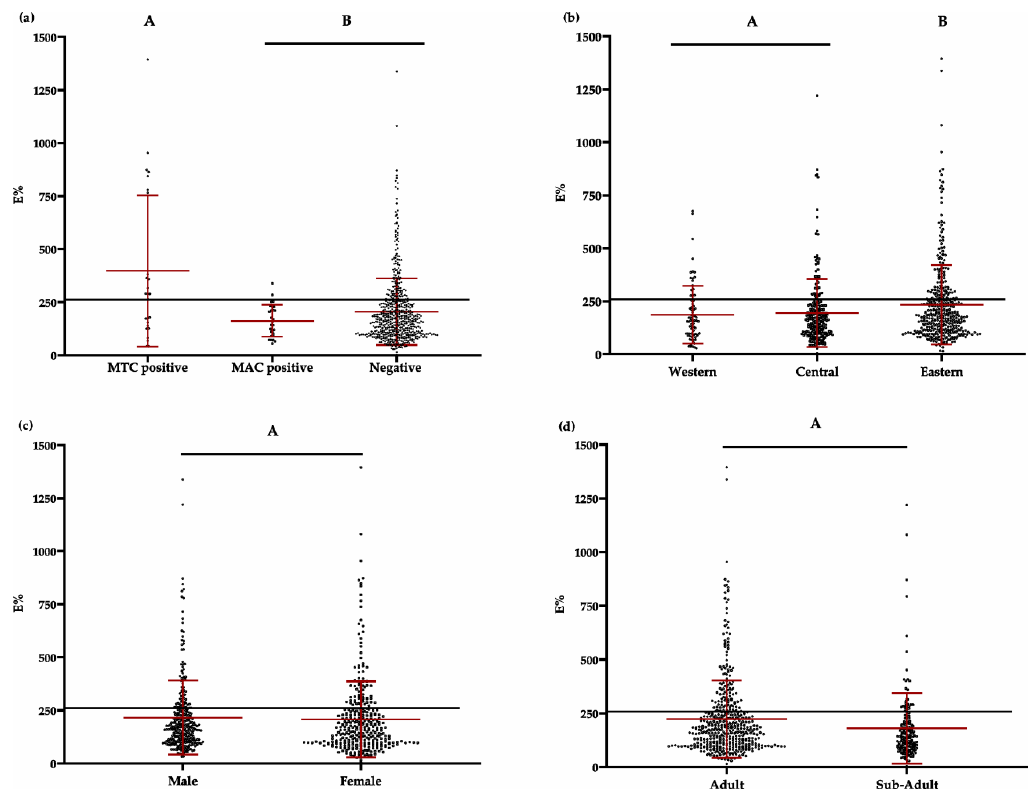
Figure 5. Proportions of badgers testing positive based on E% value in the P22 ELISA. ( a ) Positive badgers for Mycobacterium tuberculosis complex (MTC), positive for the M. avium complex (MAC), or negative for both complexes. ( b ) Positive badgers in western, central, and eastern parts of Asturias. ( c ) Male and female positive badgers. ( d ) Adult and sub-adult positive badgers. In all graphs, the horizontal black line represents the cut-off of 260% (see Section 2.3.1.3.). The red lines represent means and standard deviations. Data connected with the same letter (A or B) are not significantly different based on Tukey–Kramer’s test ( p > 0.05). Results from animals in which sex or age class were unknown are not included in panels c and d.